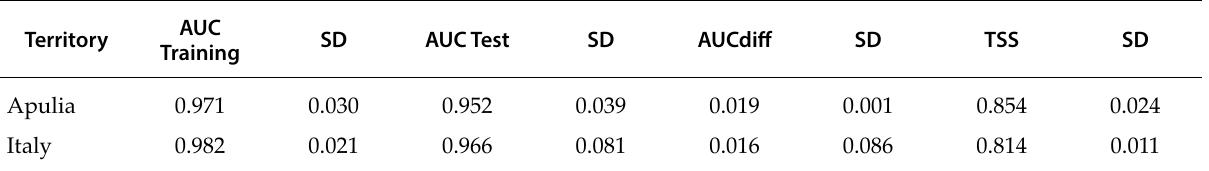
Table 2. Predictive performances (mean and standard deviation values) achieved for species distribution models devel- oped for Xylella fastidiosa in Apulia and the rest of Italy.